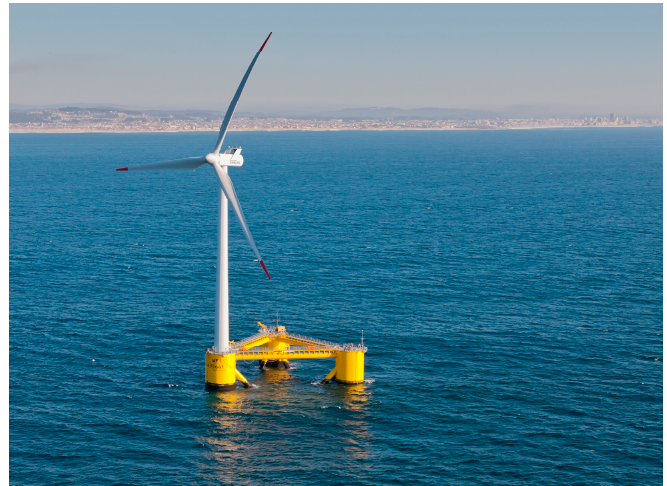
Figure 1. WindFloat: a semisubmersible floating 2 MW offshore wind turbine installation offshore Aguçadoura, Portugal. (Source: A semi-submersible type floating offshore wind turbine foundation called the WindFloat operating at rated capacity (2 MW) approximately 5 km offshore of Agucadoura, Portugal by Untrakdrover, retrieved from https://en.wikipedia.org/wiki/File:Agucadoura_WindFloa t_Prototype.jpg. Used under Creative Commons Attribution-Share Alike 3.0 Unported license).